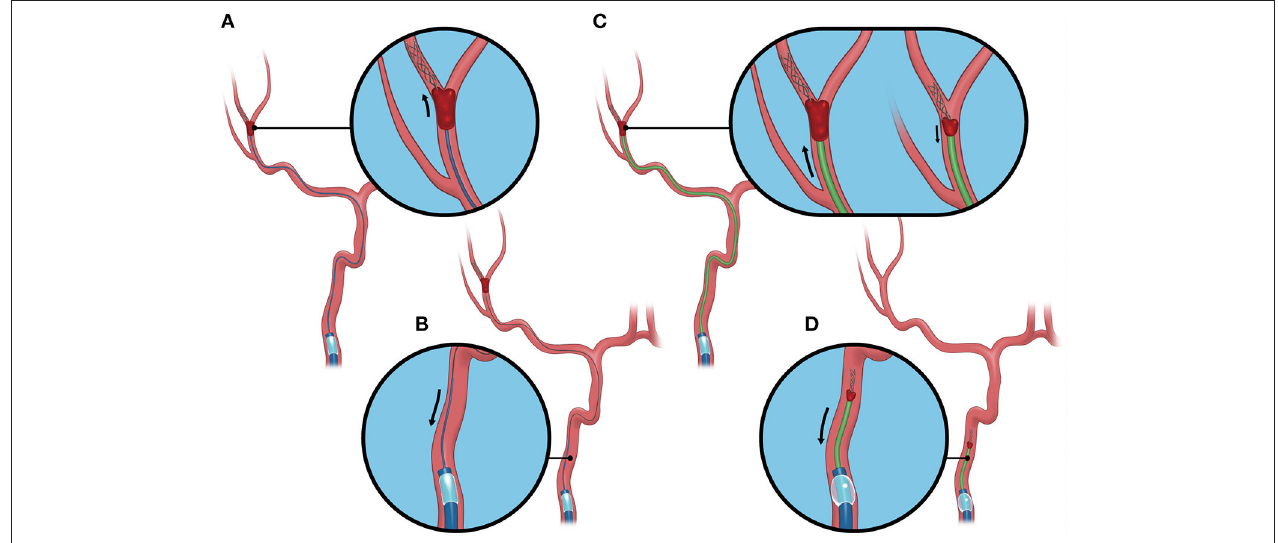
FIGURE 3 | Blind exchange and mini-pinning using a Tron stent retriever to retrieve a clot. Illustrative example of the blind exchange and mini-pinning technique using a Tron stent retriever to treat a middle cerebral artery M2 occlusion. We routinely place a large-bore balloon guide catheter in the cervical internal carotid artery. (A) The biaxial system, including the microcatheter and microguidewire, is advanced as a unit, with the microcatheter and guidewire traversing the occluded segment. The Tron stent retriever is deployed via a 0.0165-inch microcatheter distal to the clot. (B) In the next step, the microcatheter is removed from the body. (C) A 3MAX or 4MAX aspiration catheter, as a distal aspiration catheter, is blindly navigated over the bare Tron delivery wire (“blind exchange”) until the aspiration catheter reaches the clot. ( C , left) The Tron stent retriever is pulled into the distal aspiration catheter like placing a bottle cork, and the pinned clot with the stent retriever and the distal aspiration catheters then forms a single unit. ( C , right). (D) The Tron stent retriever and aspiration catheter are subsequently retracted as a unit to retrieve the